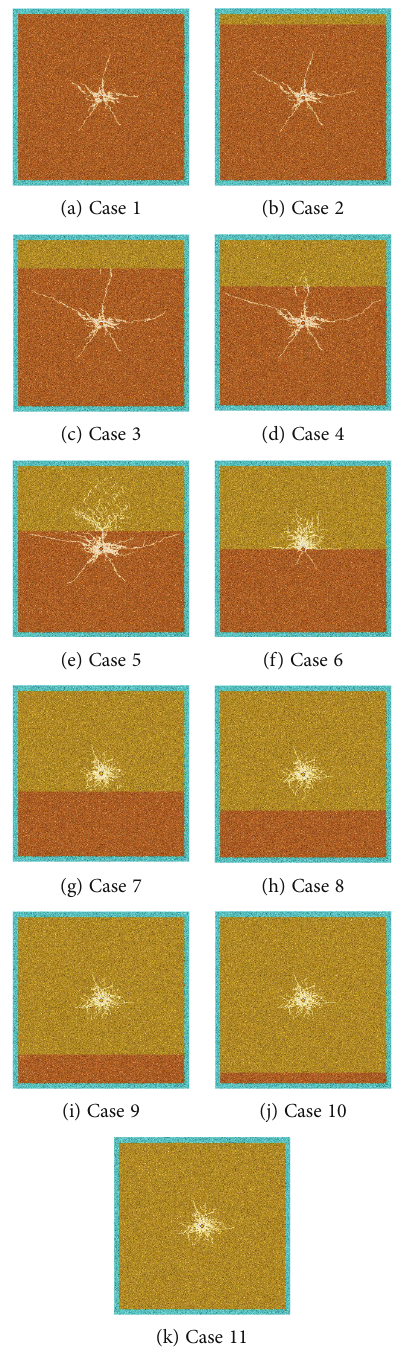
Figure 11: Blasting e ff ect drawing under di ff erent working